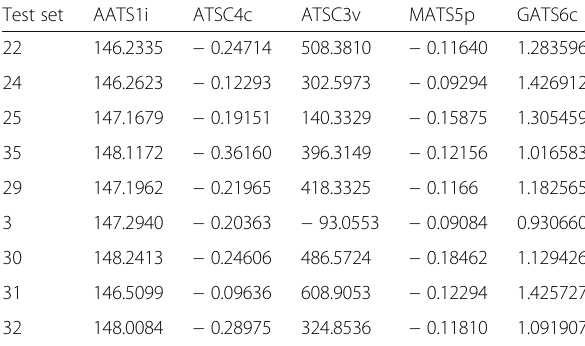
Table 5 Predicted descriptors score values for external test set compounds (model